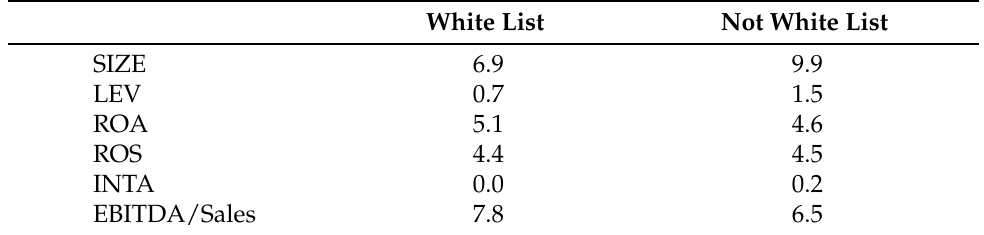
Table 2. Financial and economic performance indexes (Average value during period